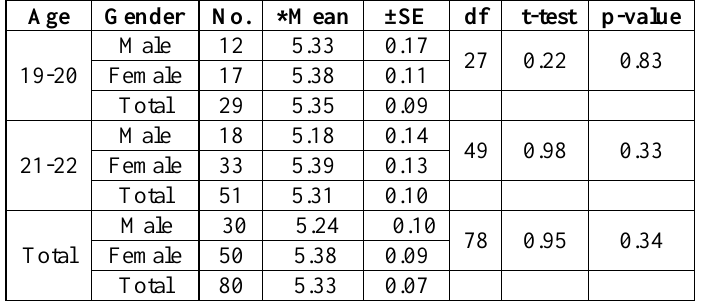
Table 4: Salivary copper concentration (µg/dl) by age and gender Age Gender No.